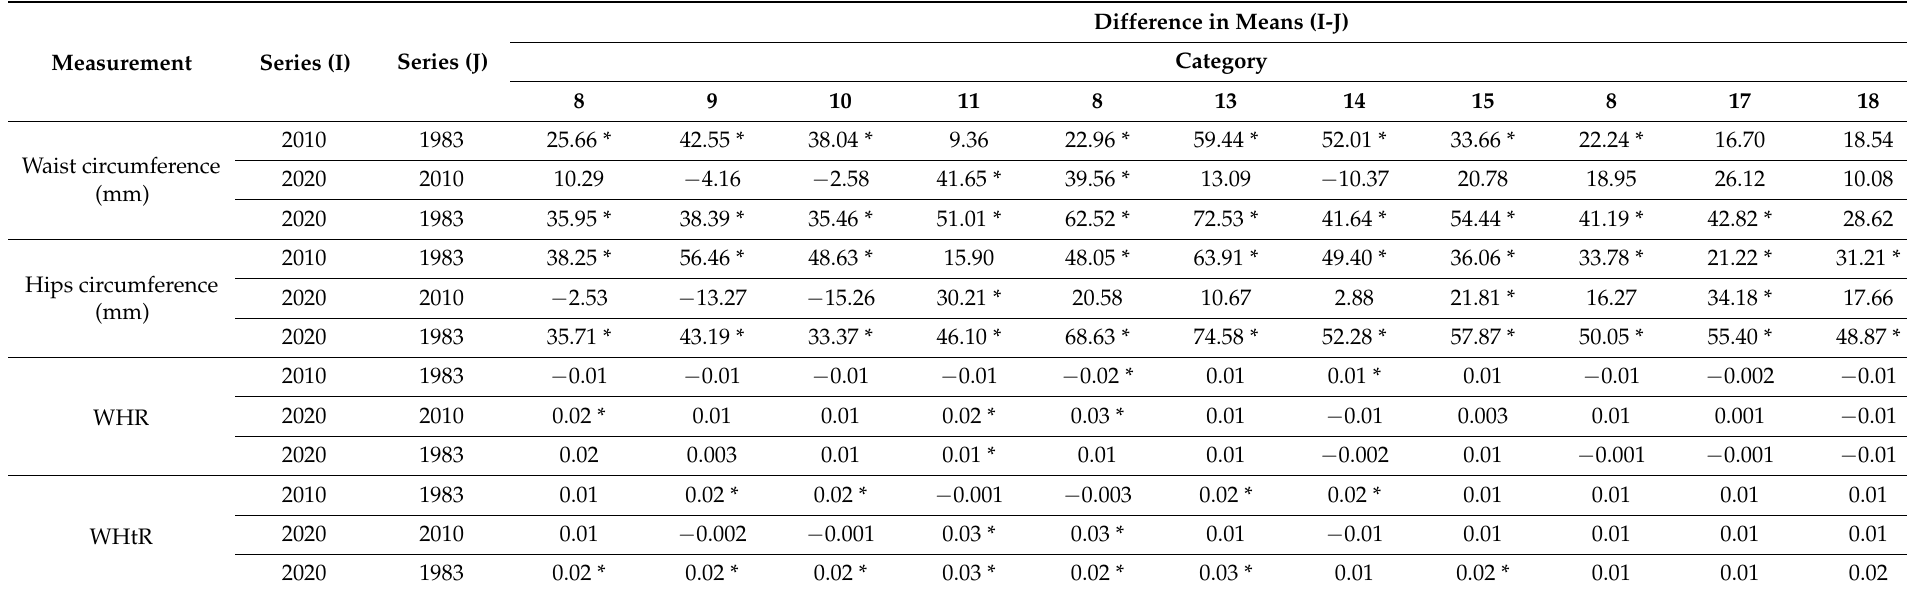
Table 5. Differences between mean values of the analyzed characteristics between cohorts and age categories for